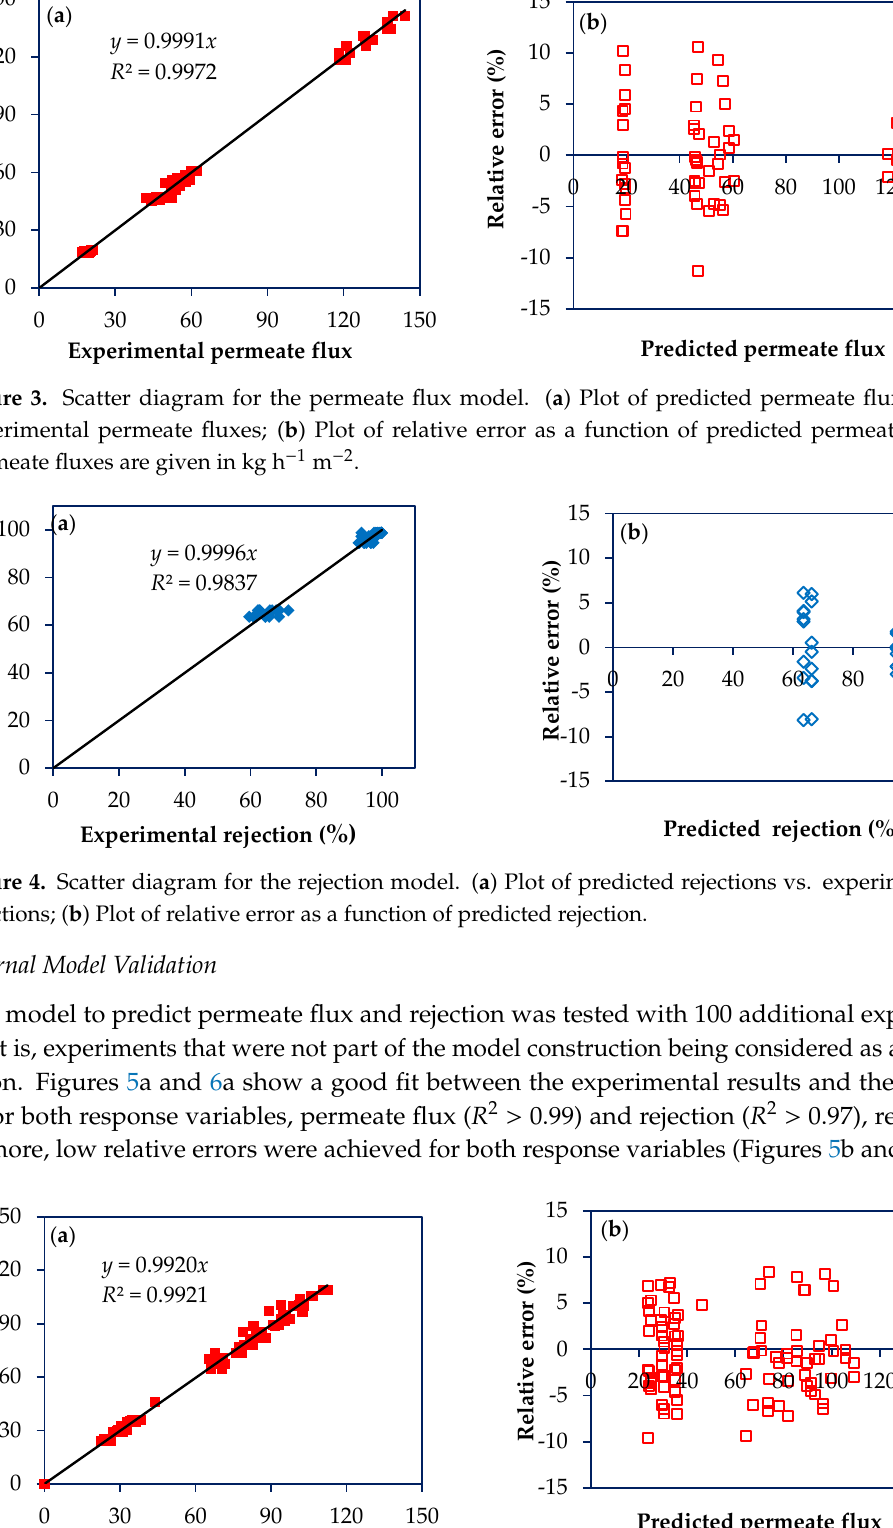
Figure 5. Scatter diagram for rejection data external to the model. ( a ) Plot of predicted rejections vs. experimental rejections; ( b ) Plot of relative error as a function of predicted rejection.